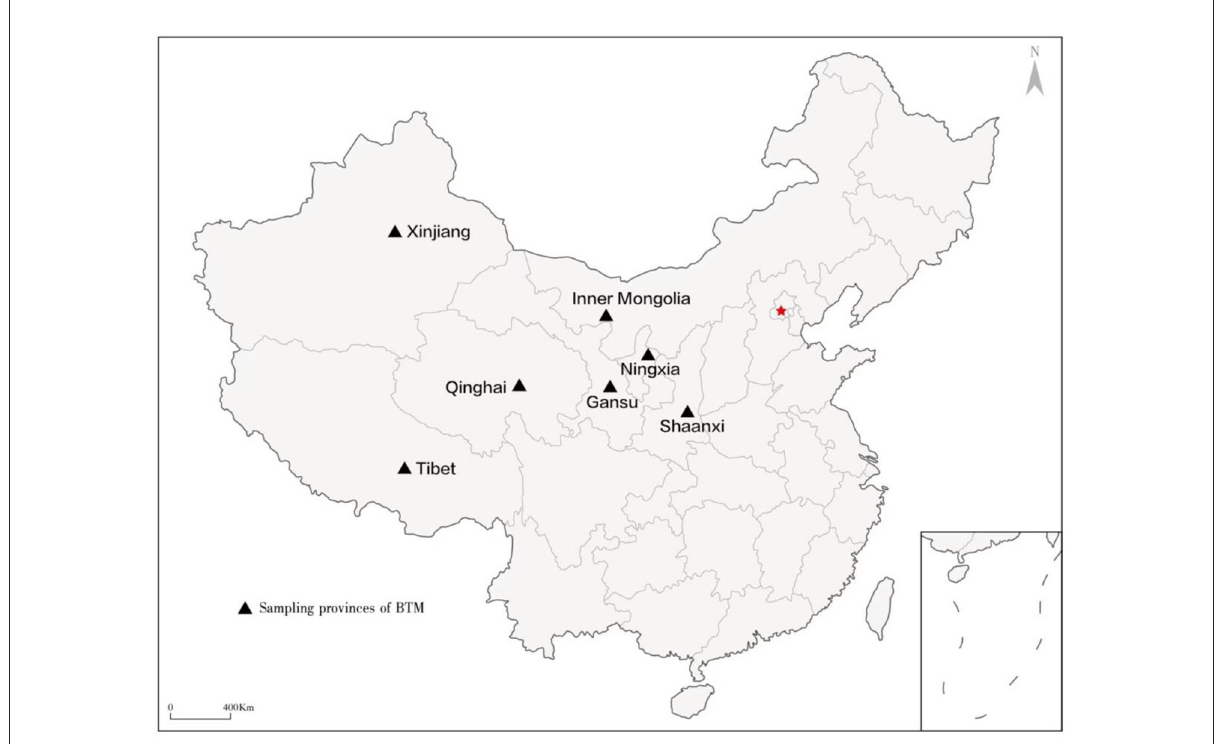
FIGURE1 Sampling regions (provinces in western China) involved in this